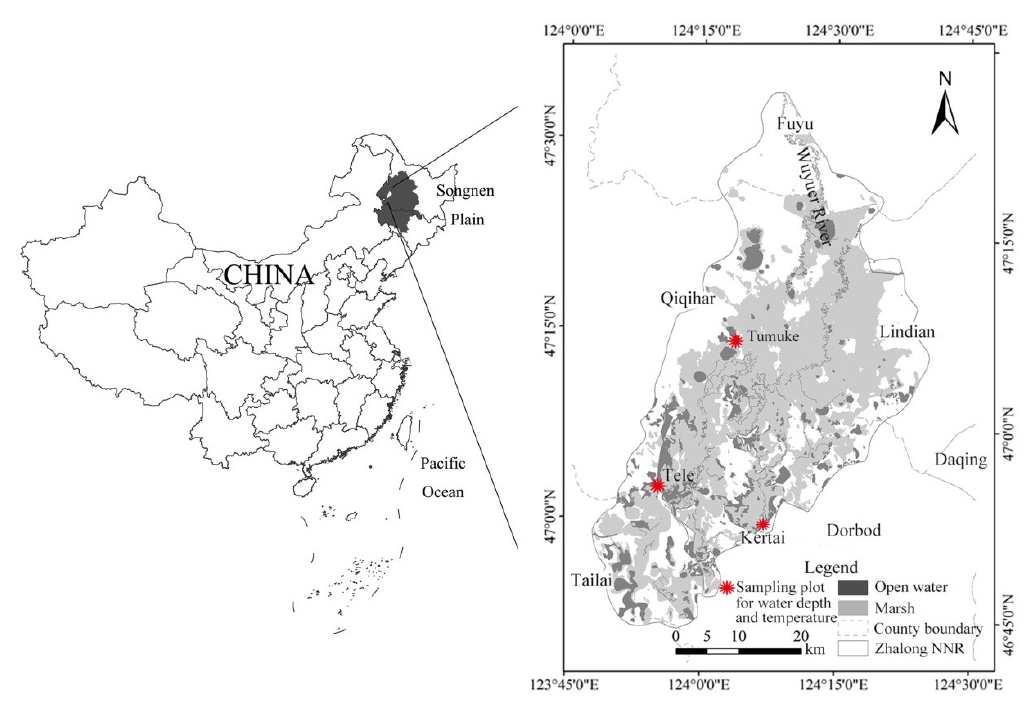
Figure 1. Location of the study area and observation sites.